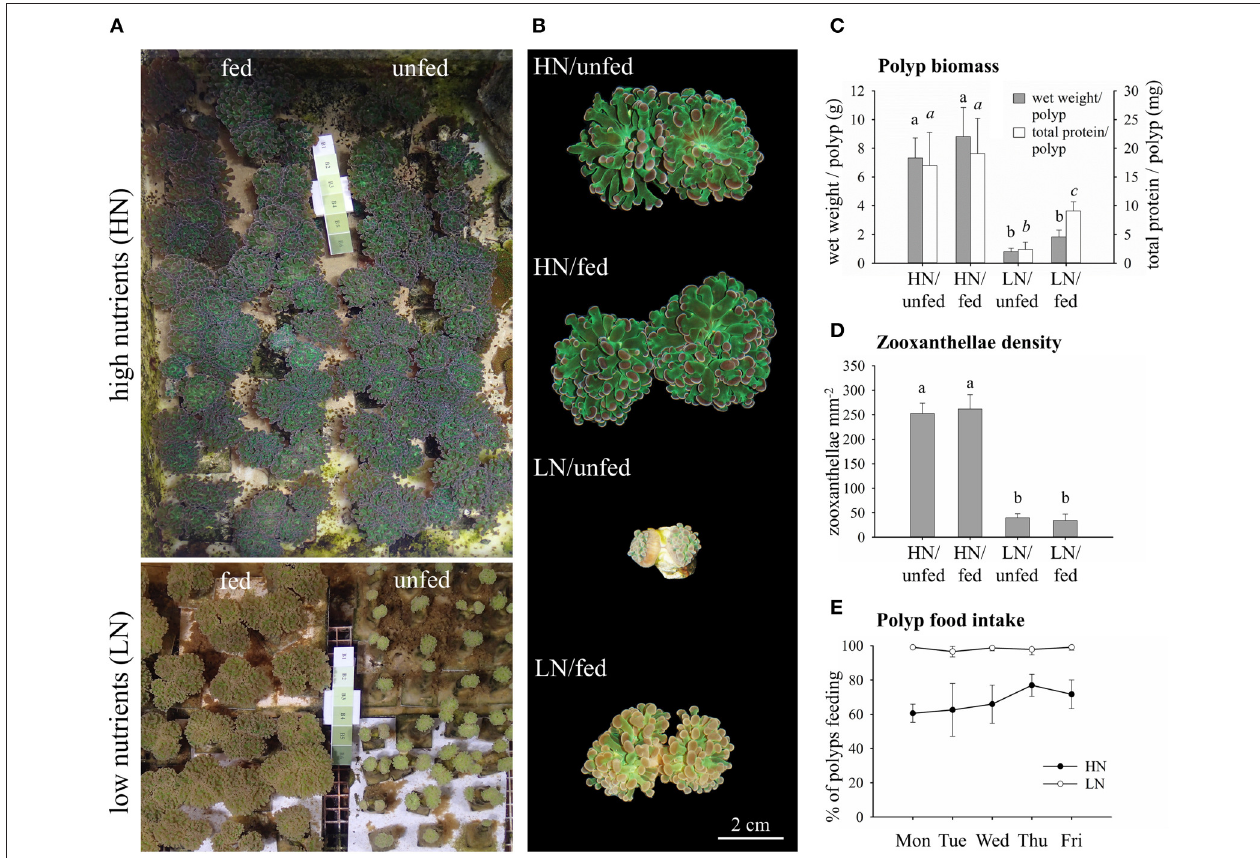
FIGURE 1 | Effects of the dissolved inorganic nutrient availability and heterotrophic feeding on E. paradivisa polyp biomass, zooxanthellae density, and feeding behavior. (A) Photographs of corals cultured under high or low availability of dissolved inorganic and particulate organic nutrients. (B) Close ups of individual polyps. (C) Wet weight and total protein content of whole polyps (HN/unfed n = 5 , HN/fed n = 4 , LN/unfed n = 4 , LN/fed n = 5 ). (D) Zooxanthellae cell density per mm 2 of ∼ 500nm thick tentacle sections ( n = 4 ). (E) Daily food intake of polyps measured as per cent of polyps feeding ( n = 4 ). Data are presented as mean and standard deviation. Different letters indicate statistically significant differences among